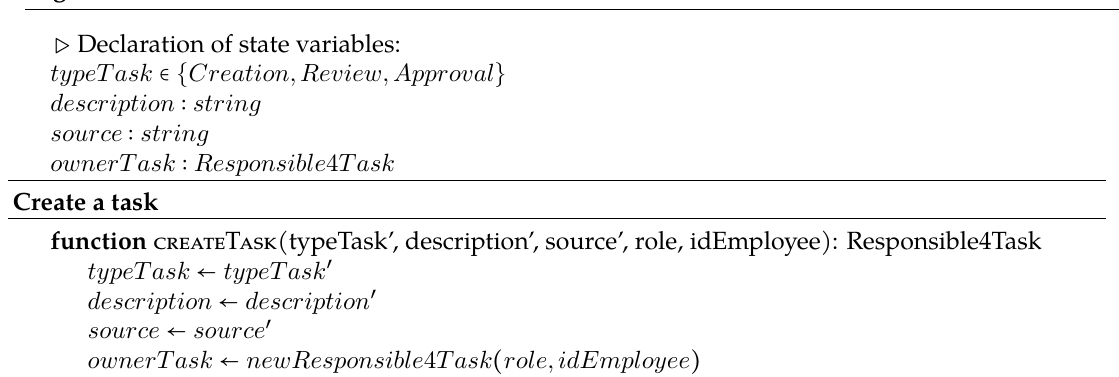
Algorithm 2 Smart Contract: